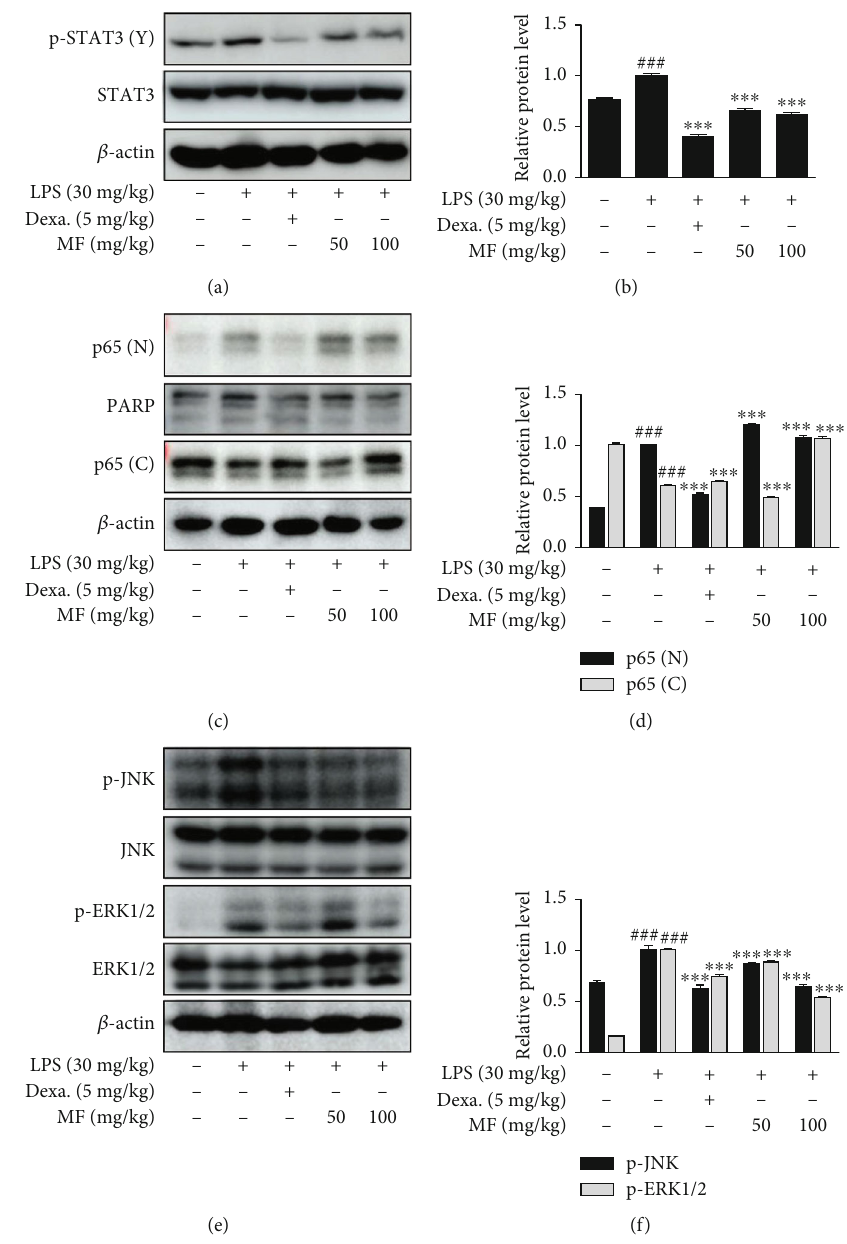
Figure 2: E ff ect of MF on LPS-induced activation of STAT3, NF- κ B p65, and MAPKs in LPS-challenged mice. Mice were intraperitoneally injected with either di ff erent concentrations of MF (50 and 100mg/kg), Dexa (5 mg/kg), or vehicle (PBS), 1h before intraperitoneal LPS injection (30 mg/kg). Liver tissue samples were obtained 4 h posttreatment with LPS, to extract protein. (a) Phosphorylated-STAT3, (c) nuclear and cytosolic NF- κ B p65, and (e) phosphorylation of JNK and ERK1/2 were analyzed by western blot. (b, d, and f) Densitometric analysis was performed using ImageJ software. The data are presented as mean ± SD . ### p < 0 : 001 vs. the control group; ∗∗∗ p < 0 : 001 vs. the LPS-only-challenged